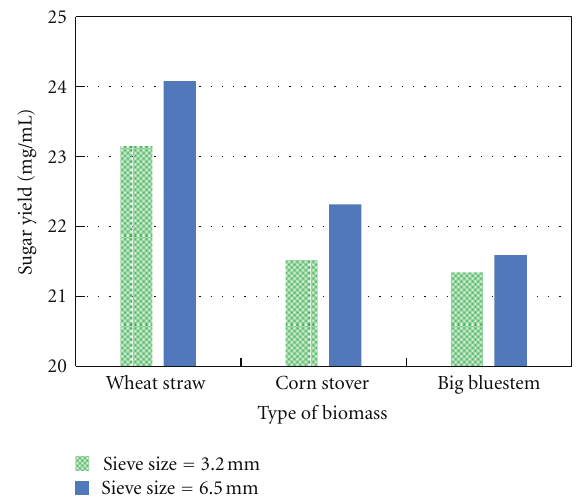
Figure 14: E ff ects of sieve size on sugar yield reported by Theerarat- tananoon et al. [37].